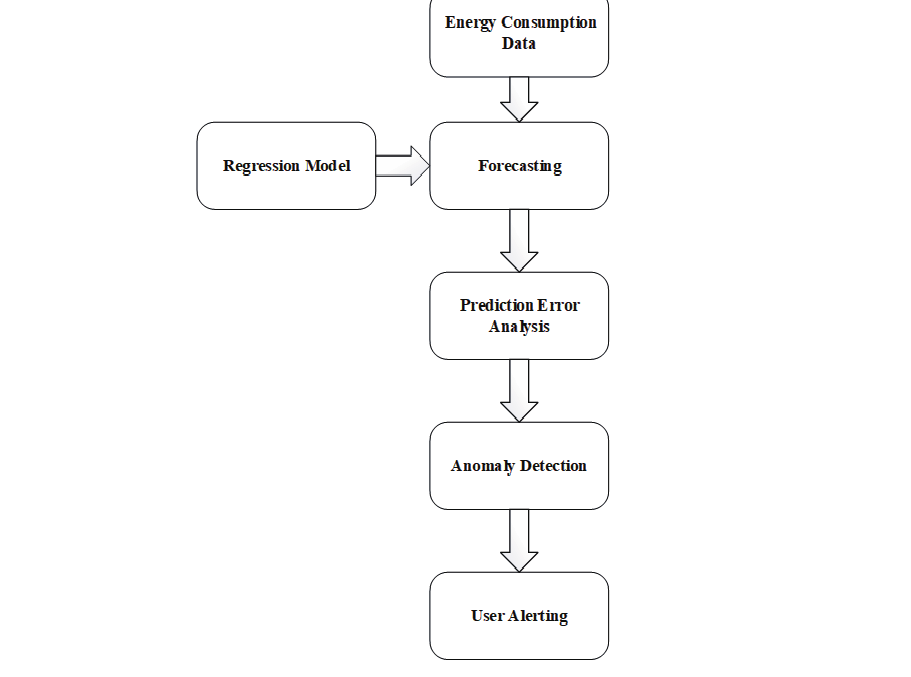
Figure 2. Process of anomaly